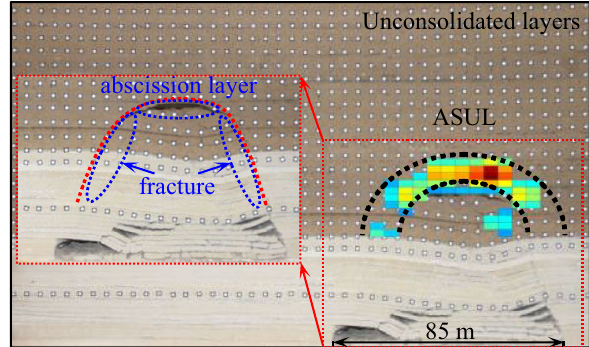
Figure 8. Morphological characteristics of the